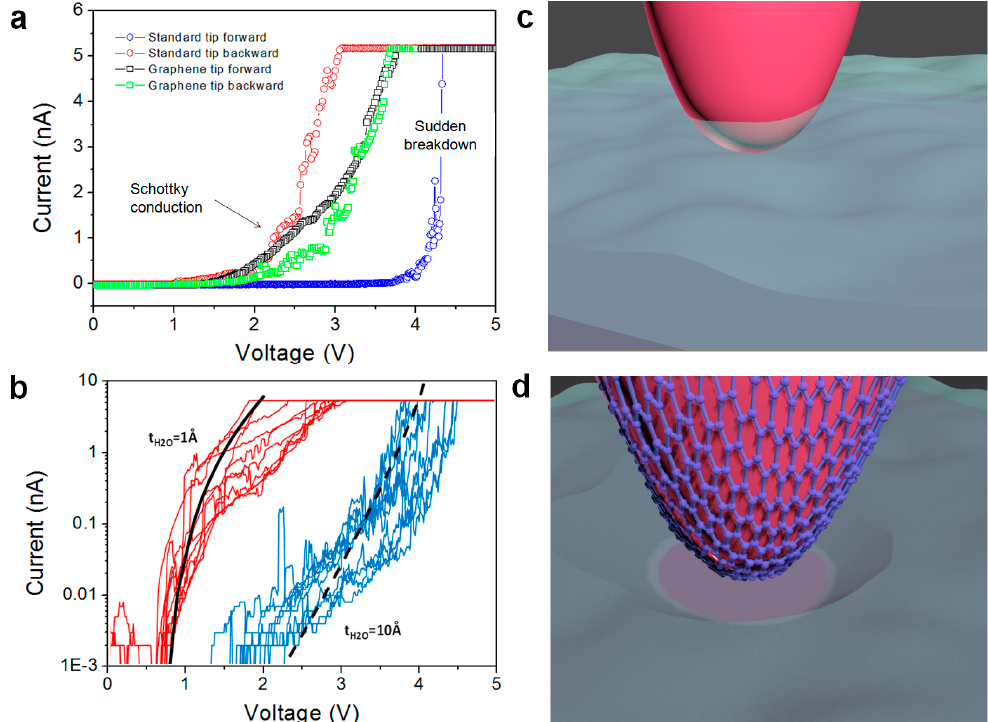
Figure 10. ( a ) Typical forward and backward I–V curves collected with standard and graphene nanoprobes on a piece of n-type silicon; ( b ) Fitting of the forward and backward I–V curves collected with the standard tip to the charge transport model; 3D schematics of ( c ) standard and ( d ) graphene nanoprobe, which shows the water resistance of graphene. Reproduced with permission from [28], copyright The Royal Society of Chemistry (2016).